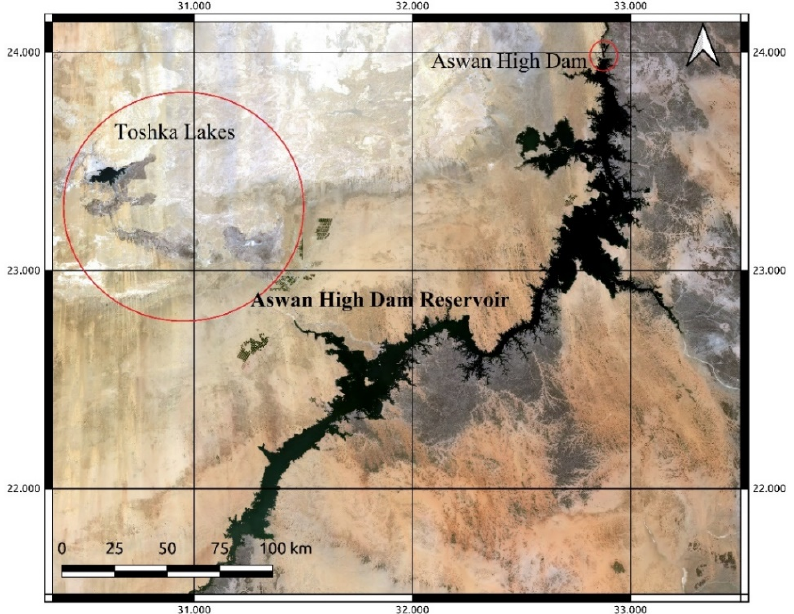
Figure 1. Mosaic of Landsat satellite image of the study area created by Google Earth Engine and further processed by QGIS.3.